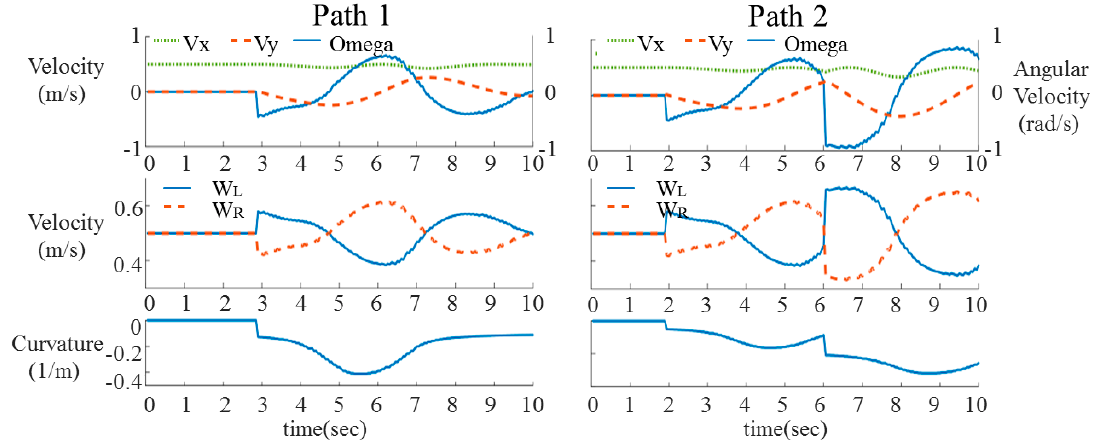
Figure 20. The linear and angular velocities, speeds of the left and right wheels and curvature profiles of the two directional navigation paths depicted in Figure 19, where v x = 0.5 is the desired constant reference longitudinal/forward/tangential speed and v y is the lateral speed of the robot.